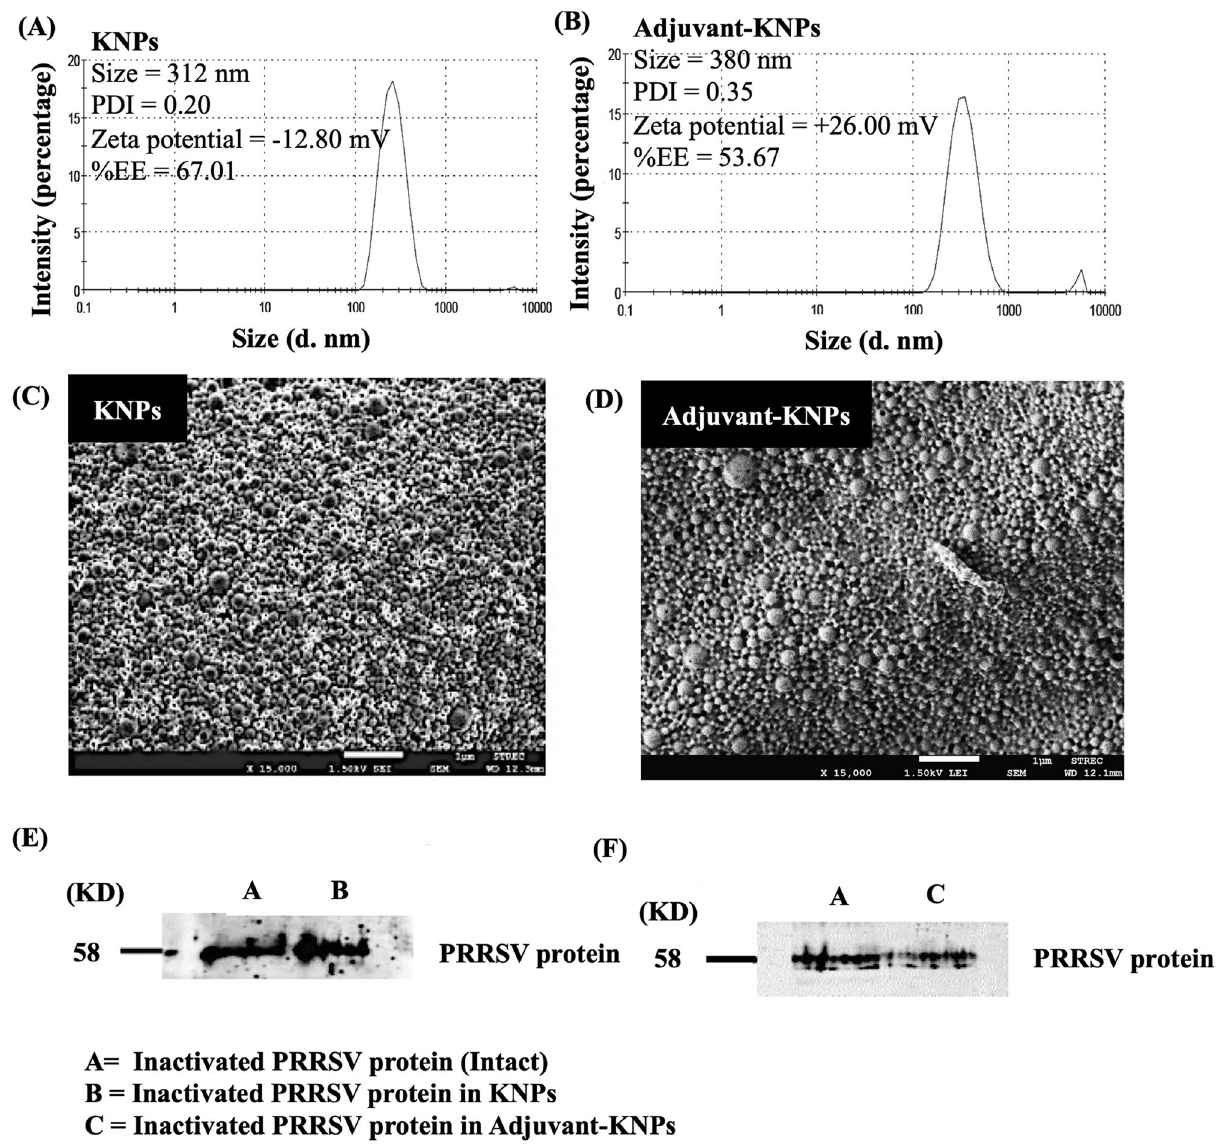
Figure 1. Characteristics of PLA nanoparticles loaded with inactivated PRRSV. Size distribution graph of the ( A ) KNPs and ( B ) adjuvant-KNPs. SEM analysis of the ( C ) KNPs and ( D ) adjuvant-KNPs (1500 × magnification). The scale bar represents 1 μm. Expression of PRRSV protein before and after encapsulation in the ( D ) KNPs and ( E ) adjuvant-KNPs. The existence of PRRSV protein was determined by western blot analysis (full blot see Supplementary Fig. S2). The total proteins in each blot were loaded in equal